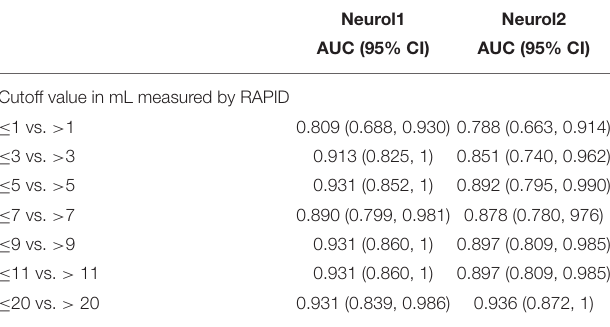
TABLE 6 | The AUC of receiver operated curves at different stroke volumes for vertebrobasilar stroke volumes with RAPID as